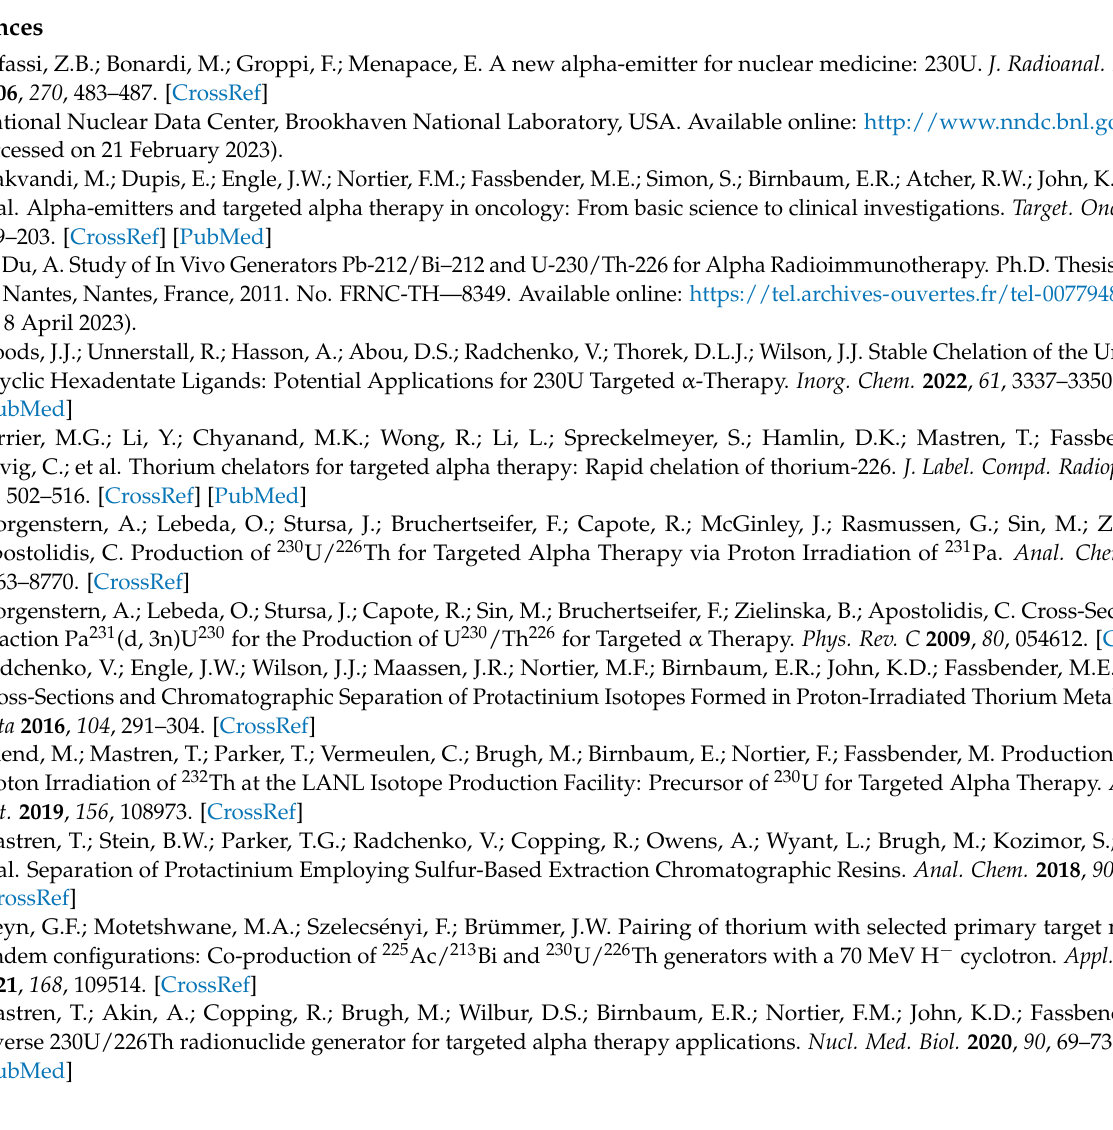
Figure A3. Illustration of 230 Pa production by a 10-day irradiation of thorium target followed by isolation and periodic extraction of 230 U (see irradiation details in [15]).